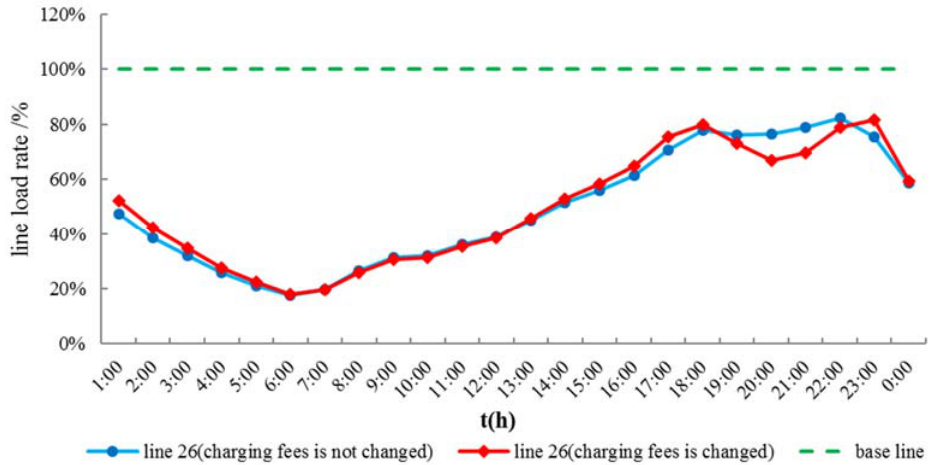
Figure A6. Line load rate of line 26 before and after adjustment for charging fees. Table A1. Charging power of each charging station at different periods in EV free charging mode.